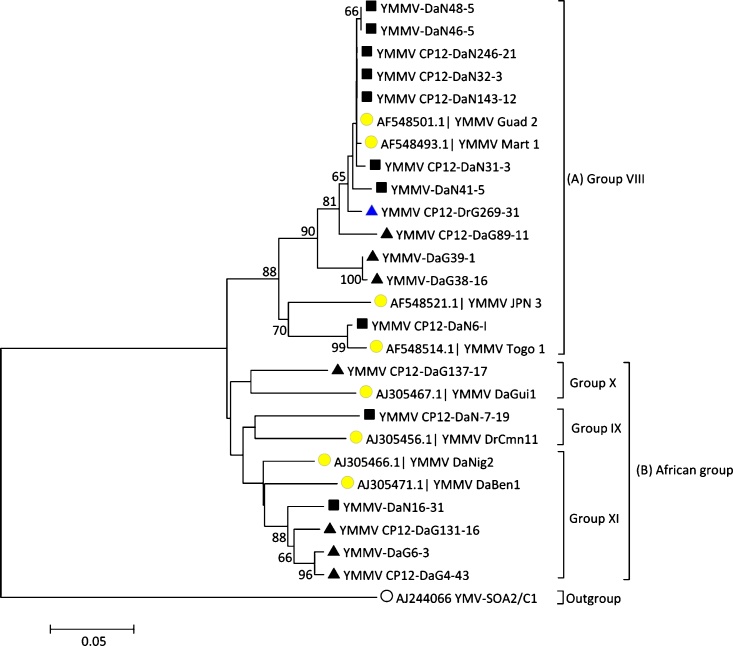
Cladogram based on full-length coat protein encoding nucleotide sequences of the 18 YMMV isolates from D. alata from Nigeria (◼) and Ghana (▲) and from D. rotundata in Ghana () in this study together with the YMMV reference isolates () from the NCBI GenBank. The tree was generated using neighbour-joining method in MEGA7 with 1000 bootstrap replications, with branches <60% were collapsed.. The percentage of trees in which the associated taxa clustered together is shown next to the branches. The scale bar represents the number of nucleotide substitutions per site.